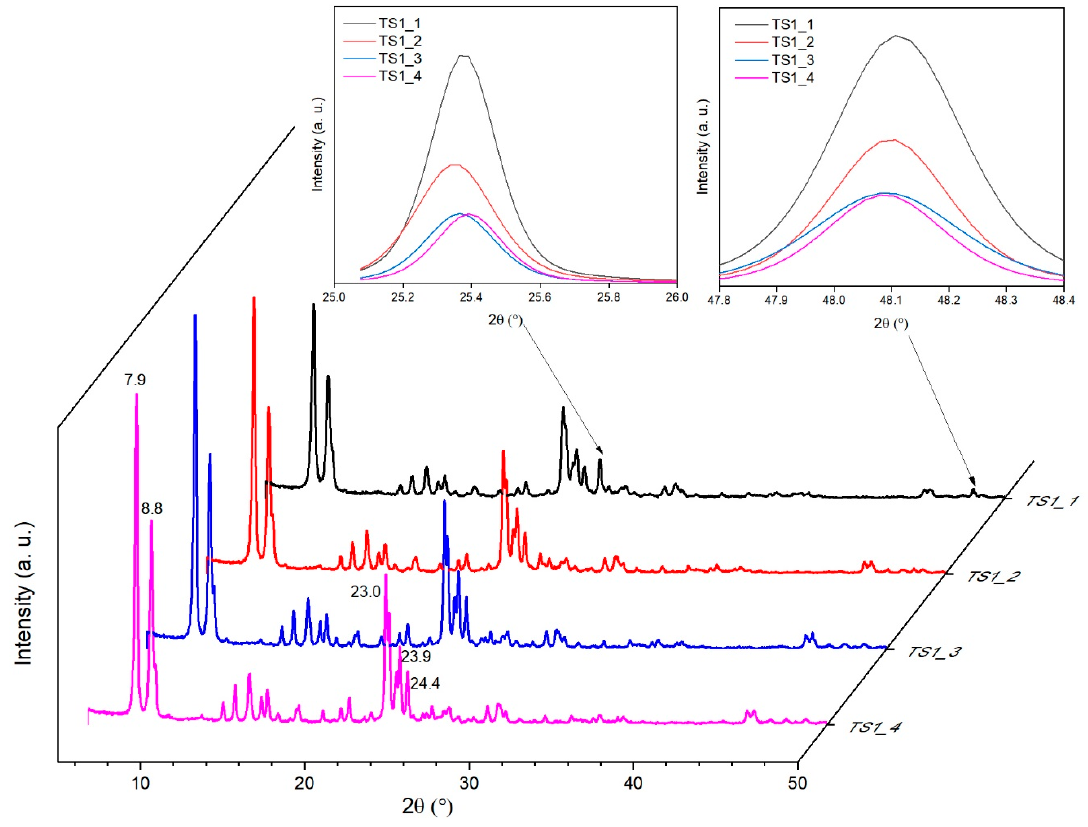
Figure 3. XRD patterns of the TS-1 materials.